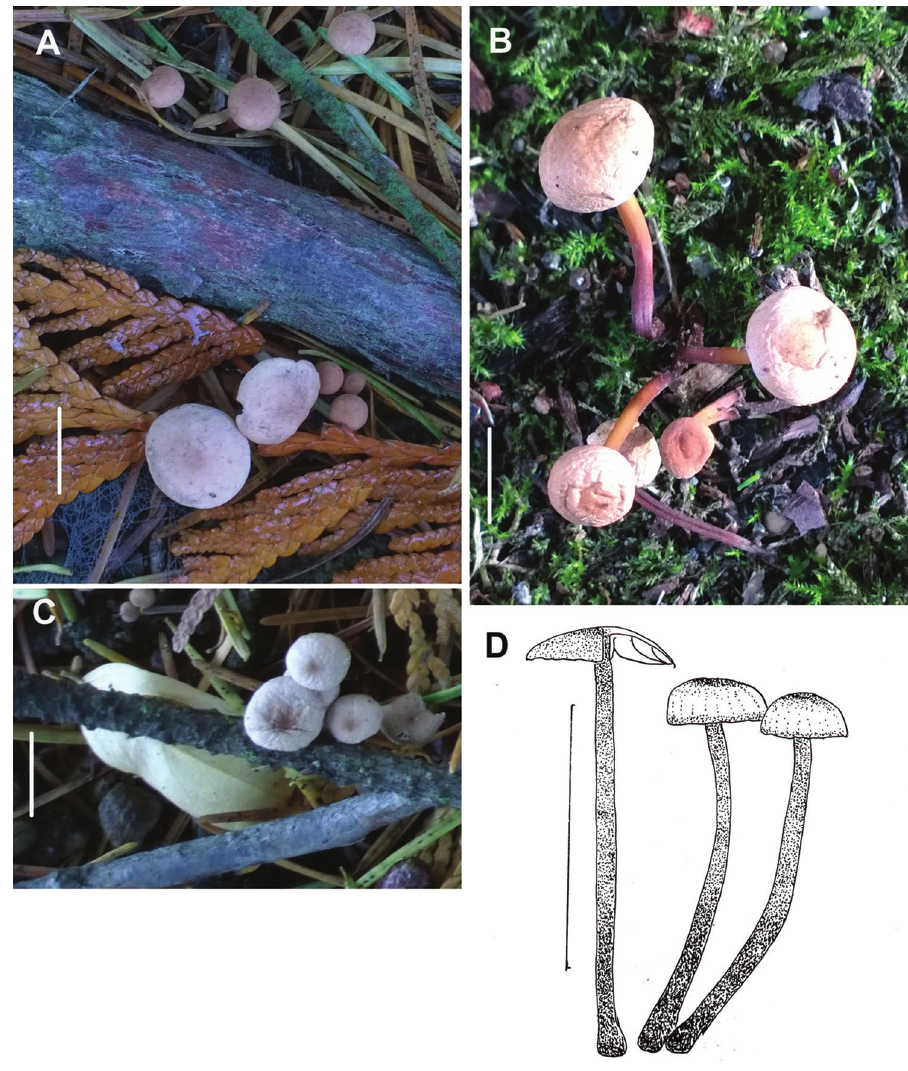
Figure 78. Mycetinis scorodonius f. diminutivus . Basidiomata. A 22200-11-4-2015 B 10961-10-20-2015 C 22167-10-14-2015 D Reconstruction from dried specimen. Standard bars: A–C = 10 mm; D = 20 mm. A–C courtesy K.